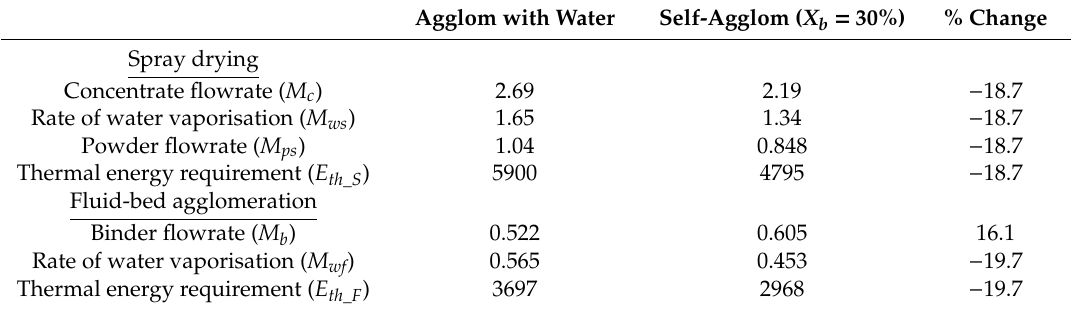
Table 2. Comparison of thermal energy requirement (and relevant flowrates) for self-agglomeration (with binder solids concentration X b = 30%) and traditional wet agglomeration (using a water binder). This is for the case of R wp ratio = 0.5 for both agglomerations. The solids concentration entering the spray-dryer is 36%. [flowrates are in kg s − 1 and thermal energy requirement is in kW]. Agglom with